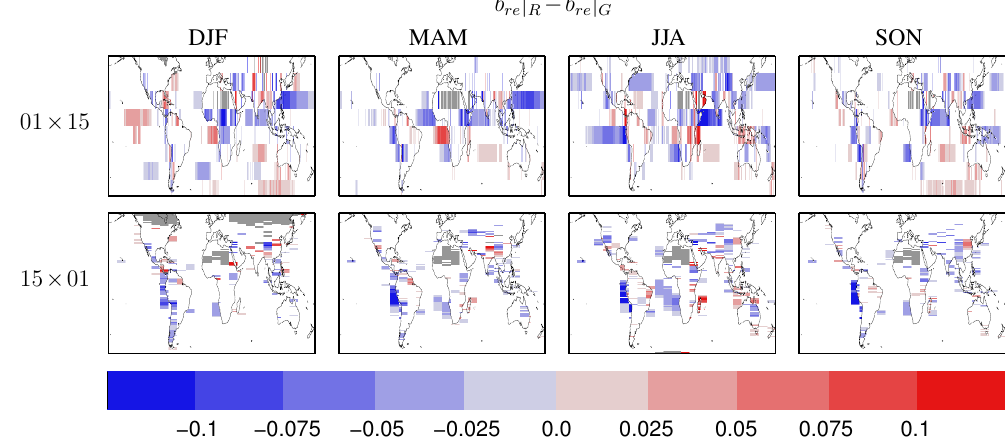
Fig. 6. Same as Fig. 6, but for sensitivity of N e to τ a . Fig. 5. Same as Fig. 3, but for sensitivity of r e to τ a .